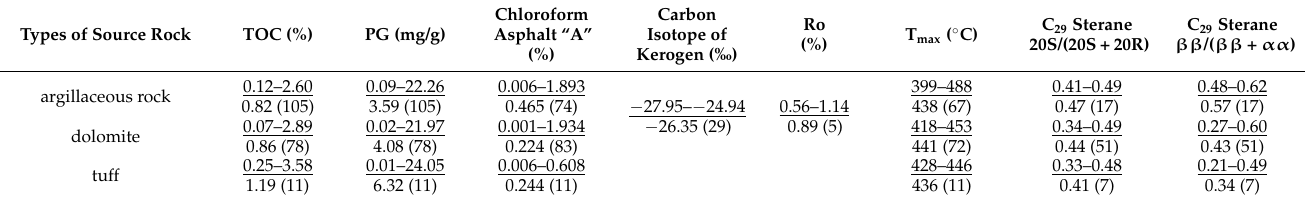
Table 1. Geochemical characteristics of different types of source rocks in the Fengcheng Formation of the Mahu Sag. Types of Source